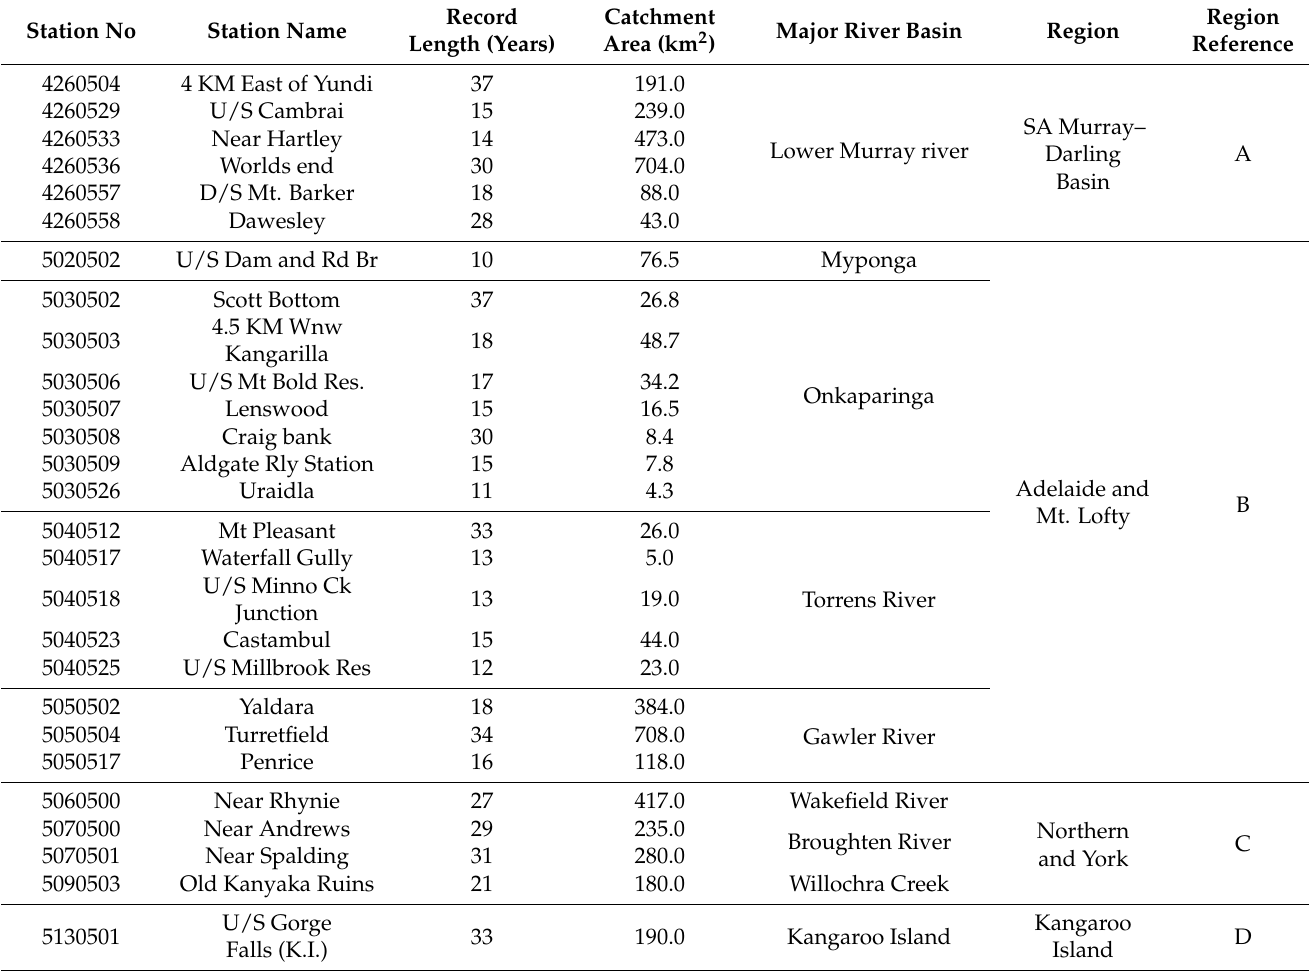
Table 1. Details of the study